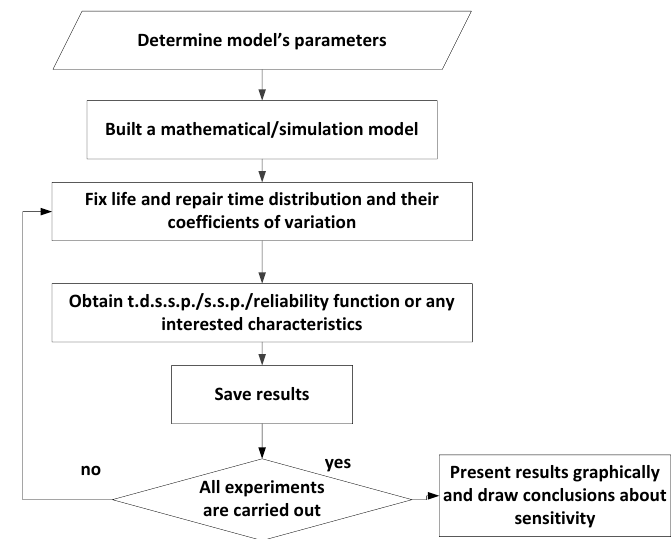
Figure 1. The general procedure for SA